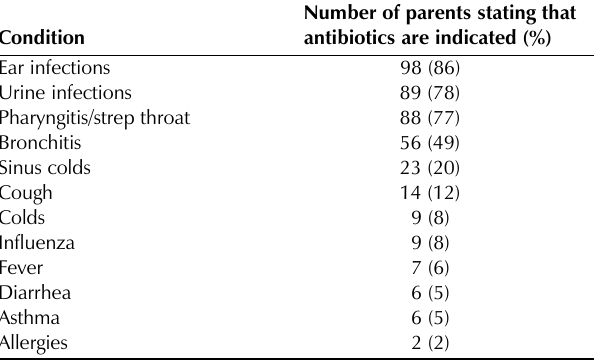
*Comparison of paediatric emergency department (PED), group paediatricians(cid:146) office (Office) and after hours walk-in clinic in group paediatricians(cid:146) office (Walk-in) (one-way ANOVA for comparison of means and χ 2 test for comparison of proportions)